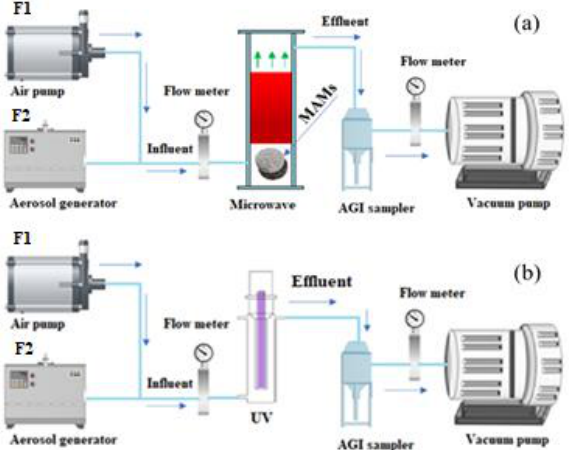
Figure 1. ( a ) Experimental setup for airborne ARB exposure to ( a ) MW and ( b ) UV irradiation MAMs: microwave absorbing